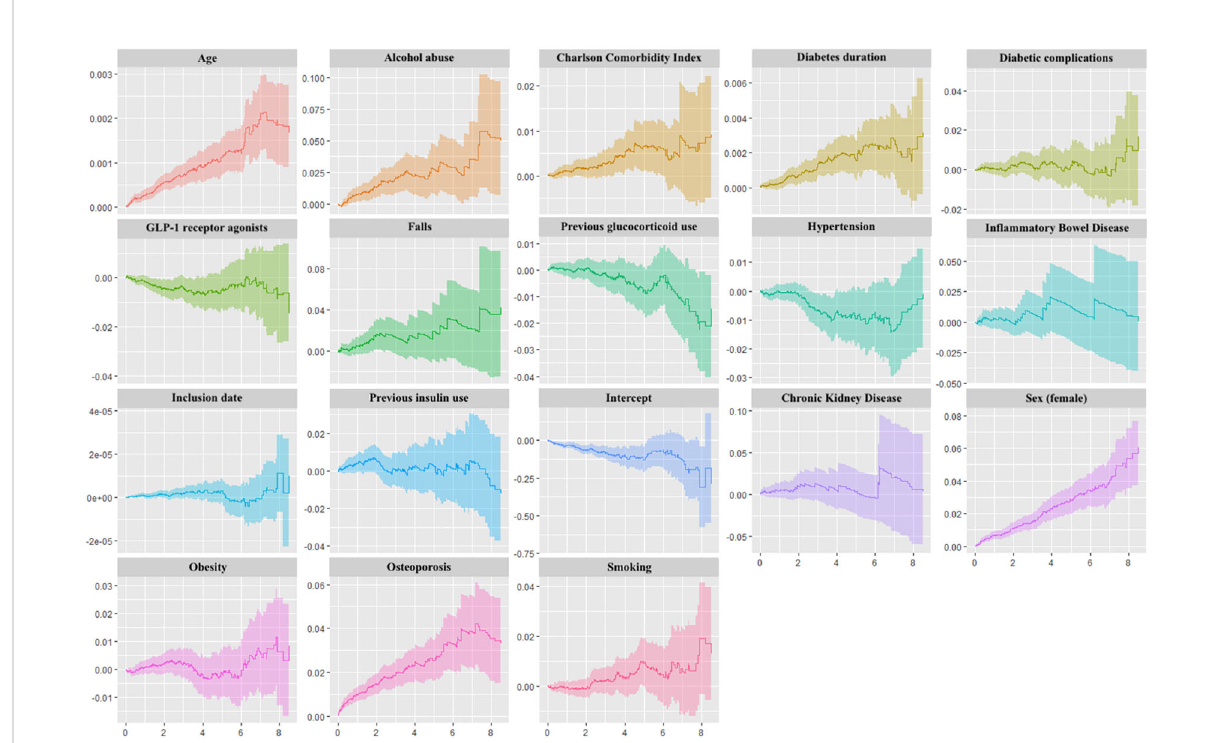
FIGURE 3 Aalen ’ s Additive Regression Plots. Plots of the time-varying additive hazards plotted against time (years) on the x-axes for covariates used in Aalen ’ s Additive Regression Model. This regression model assumes additive risks (producing hazard rate differences) rather than multiplicative risks (producing hazard rate ratios) for each covariate. The plots contain the cumulative hazards attributable to each covariate, and the slope at any point on the plot corresponds to a hazard rate; positive slopes represent increased risks, and negative slopes represent reduced risks. Note that effects may be time-varying, and the slopes can therefore be positive at one timepoint and negative at another timepoint. The intercept term represents a baseline hazard (the hazard of an individual for whom exposure and all covariate values are